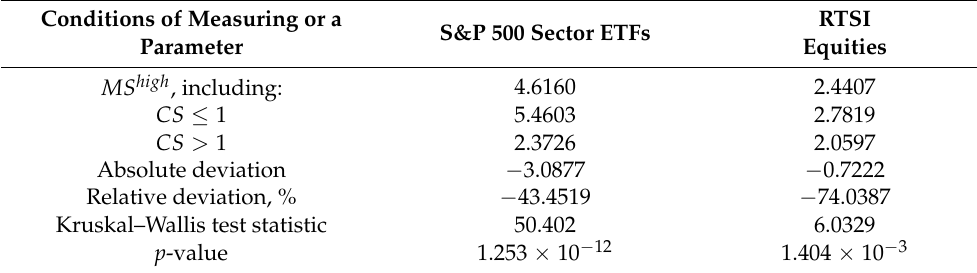
Table 3. Conditional mean value of risk on days with atypical magnitude.